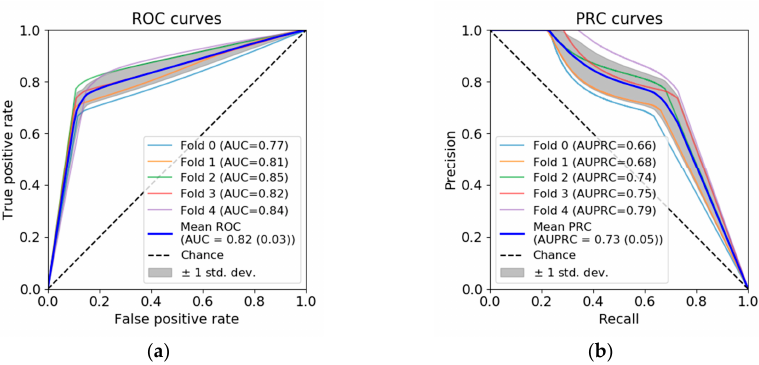
Figure 3. Automated dense segmentation of CNP. ( a ) ROC curve. ( b ) PRC curve.